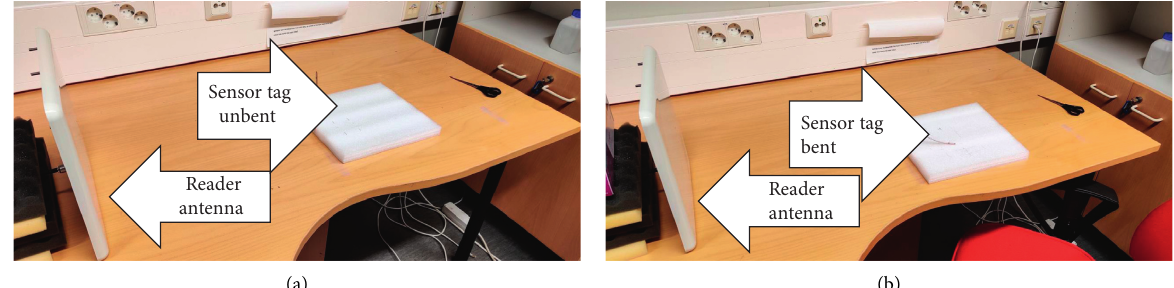
Figure 4: Arrangement of the single sensor tag test: initially (a) and after bending